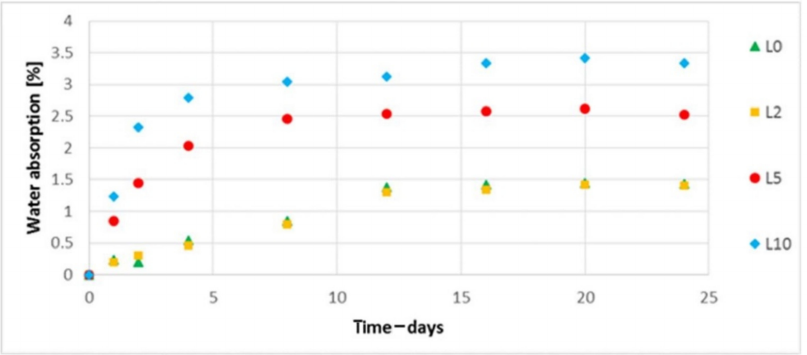
Figure 17. Water absorption of composites filled with unmodified and modified flax